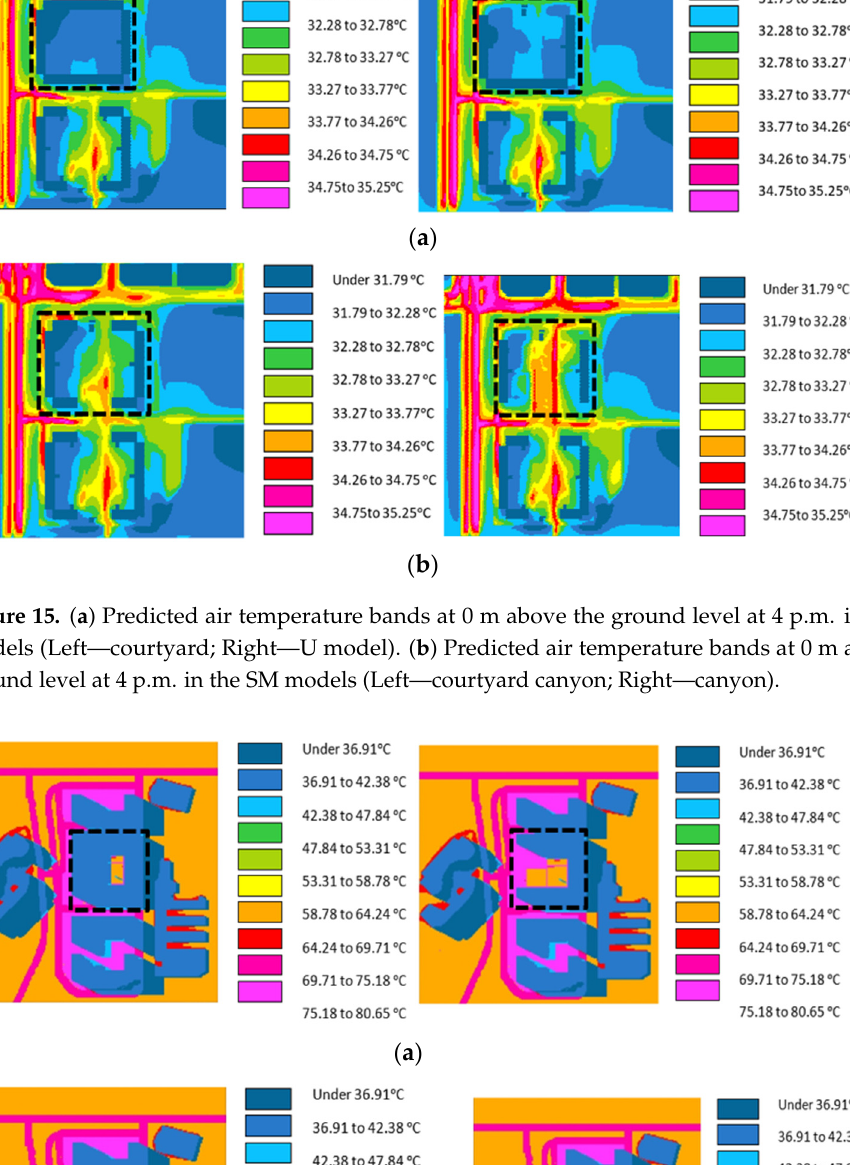
Figure 14. ( a ) Predicted air temperature bands at 0 m above the ground level at 4 p.m. in the FBTS models (Left—courtyard; Right—U model). ( b ) Predicted air temperature bands at 0 m above the ground level at 4 p.m. in the FBTS models (Left—courtyard canyon; Right—canyon).